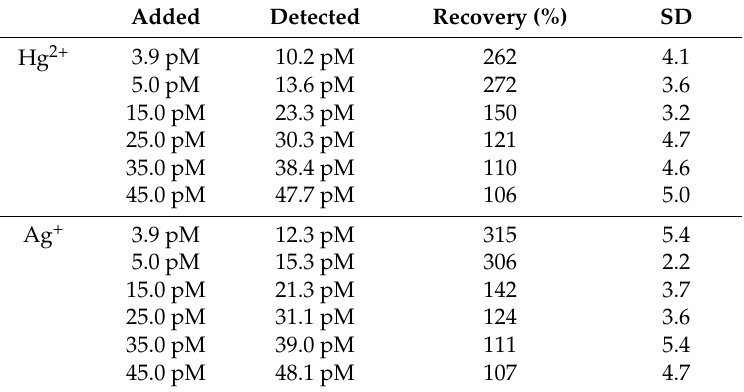
Table 4. The detection of low ion concentration.